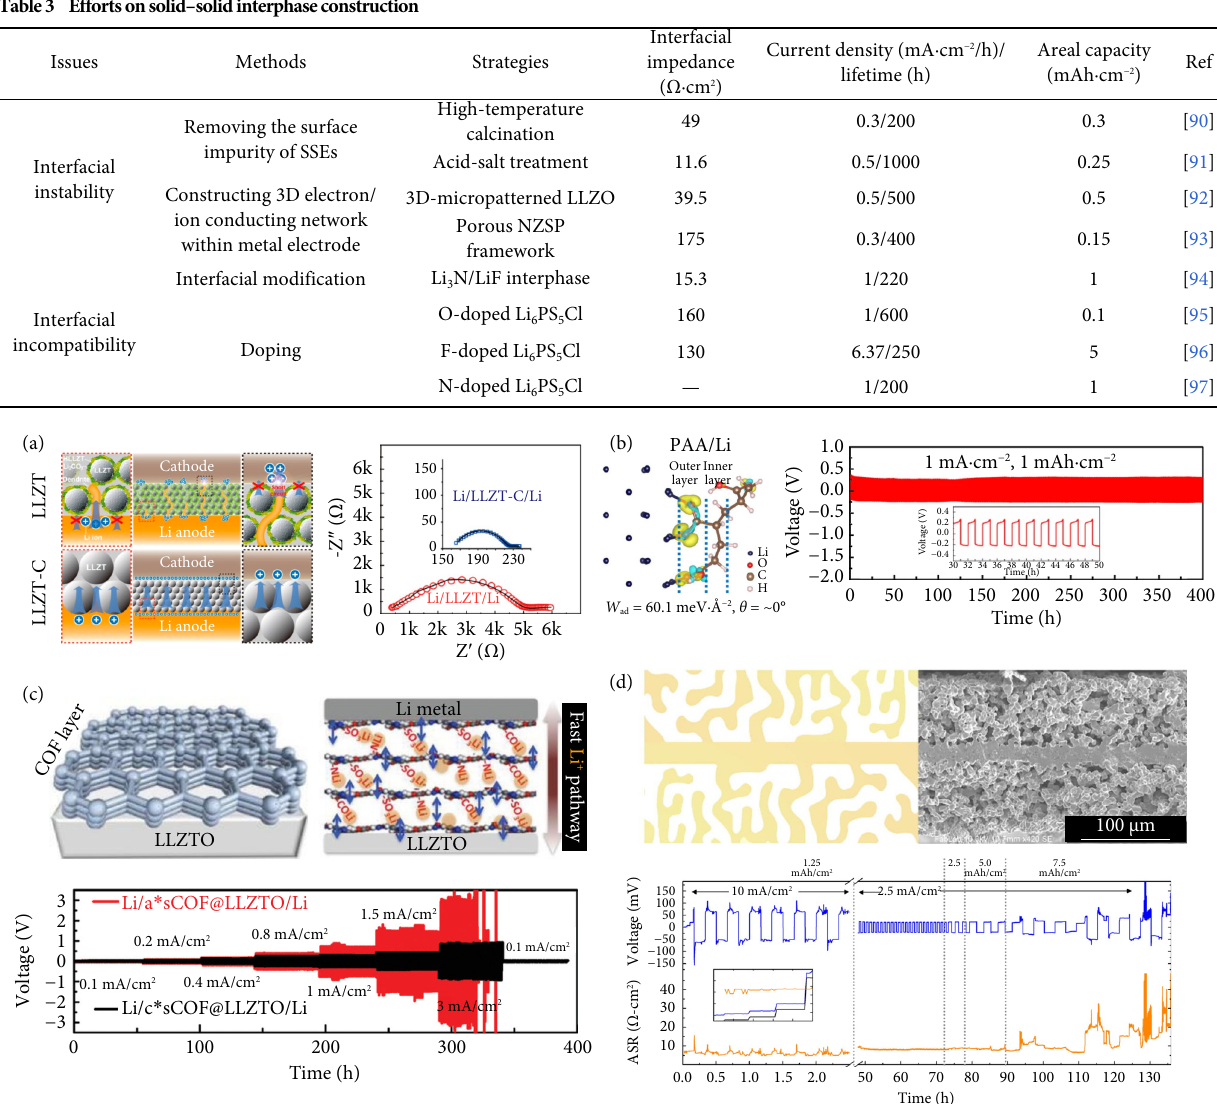
Fig. 7 (a) Schematic of the interface between Li-metal and garnet LLZT/LLZT-C, the electrochemical impedance of Li/LLZT/Li and Li/LLZT-C/Li cells (reprinted with permission from ref. [98], © 2018 American Chemical Society). (b) The structure and charge transfer at PPA/Li interfaces and the cycling performance of Li/PPA- coated LLZTO/Li cells (reprinted with permission from ref. [99], © The Author(s) 2021). (c) Schematic of self-assembly of COF on garnet SSE and Li + transfer in the COF layer and the cycling performance of Li/COF@LLZTO/Li and Li/COF@LLZTO/Li cells at various current densities (reprinted with permission from ref. [100], © 2020 Wiley-VCH Verlag GmbH&Co. KGaA,Weinh). (d) Schematic of porous-dense-porous trilayer structure of LLZTO and corresponding cross-sectional SEM images, cycling performance of Li/Li symmetric cells assembled with trilayer structure at different current density and area capacity (reprinted with permission